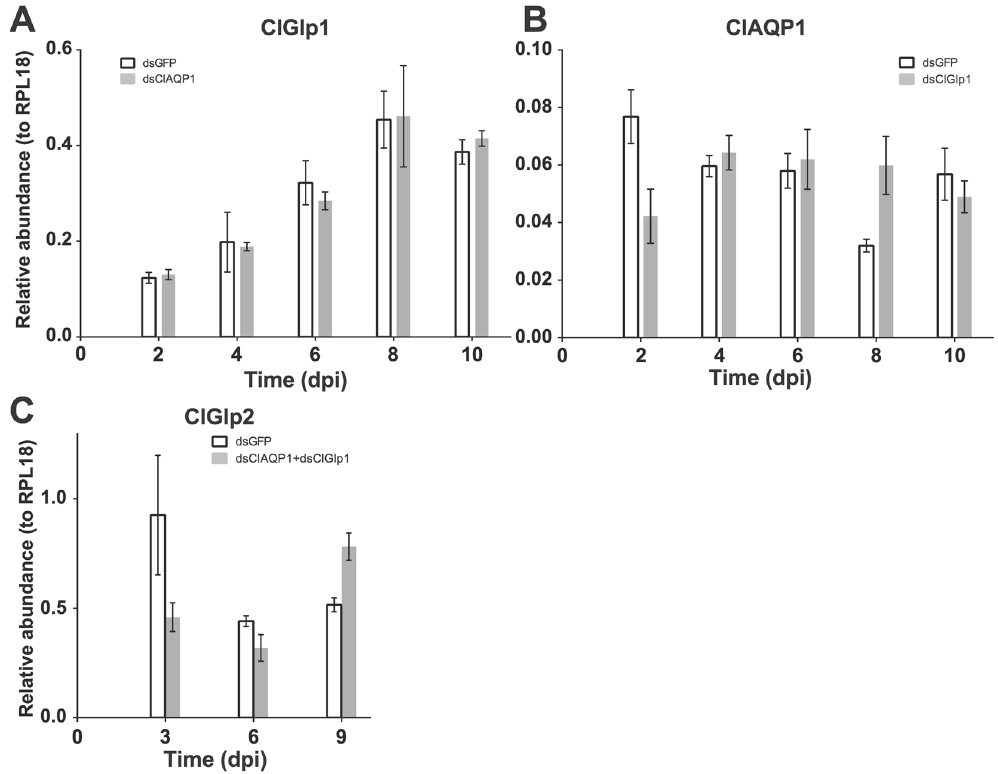
Figure 5. Lack of off-target effect of dsRNA injection. ( A ) ClGlp1 expression in dsClAQP1 (or control dsGFP) injected bed bugs. ( B ) ClAQP1 expression in dsClGlp1 (or dsGFP) injected bed bugs. ( C ) ClGlp2 expression in dsClAQP1/dsGlp1 (or dsGFP) injected bed bugs. Dpi: days post injection. The graph shows mean ±